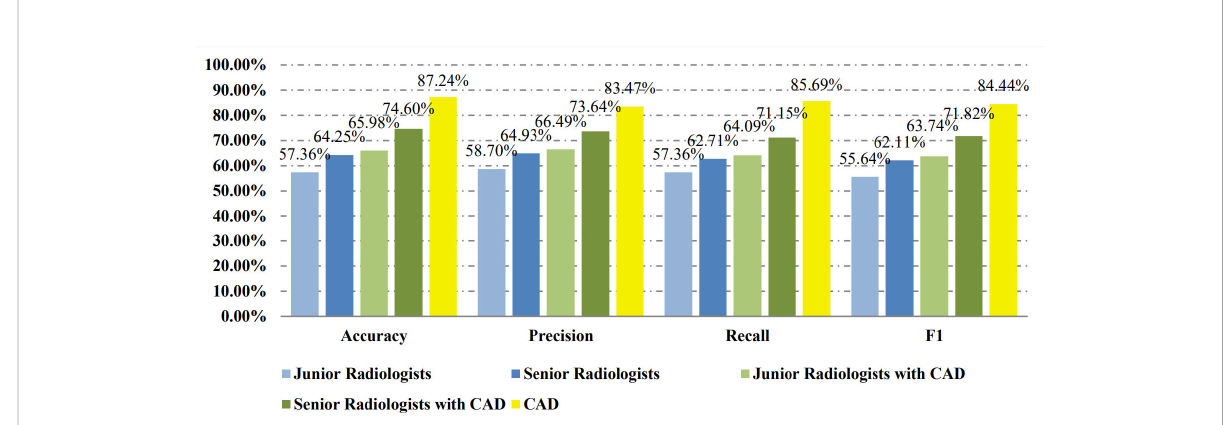
FIGURE 6 Evaluation results for CAD and different radiologists on the unbalanced data set.